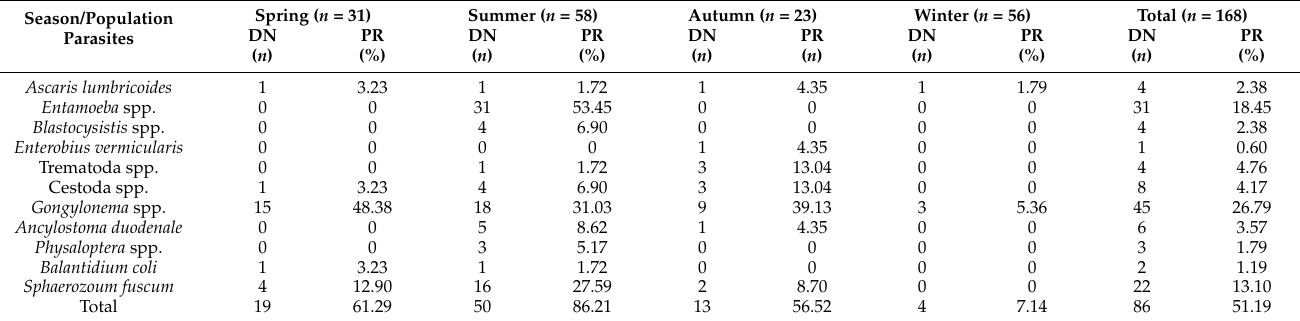
Table 4. Prevalence of intestinal parasites during different